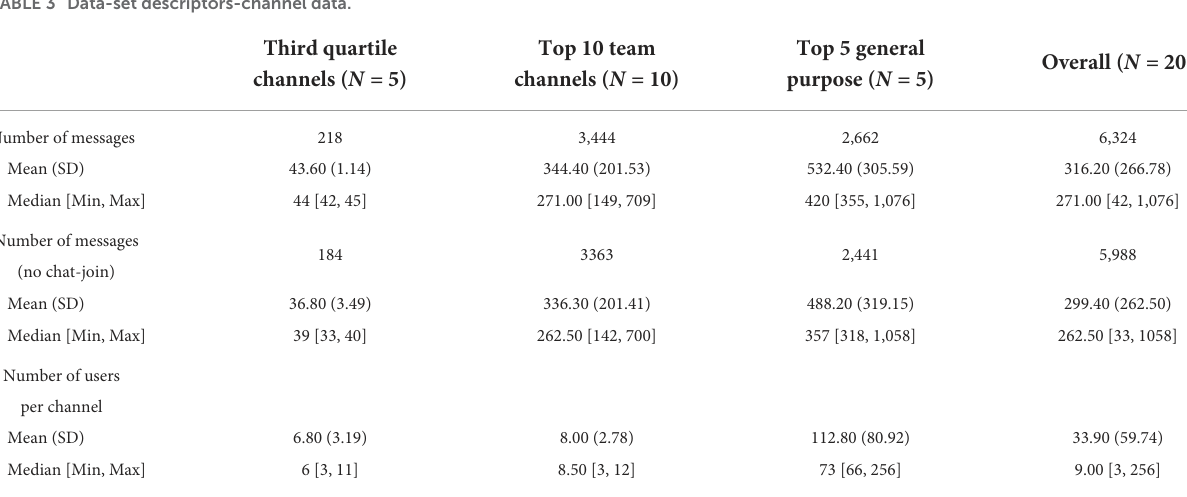
TABLE 3 Data-set descriptors-channel